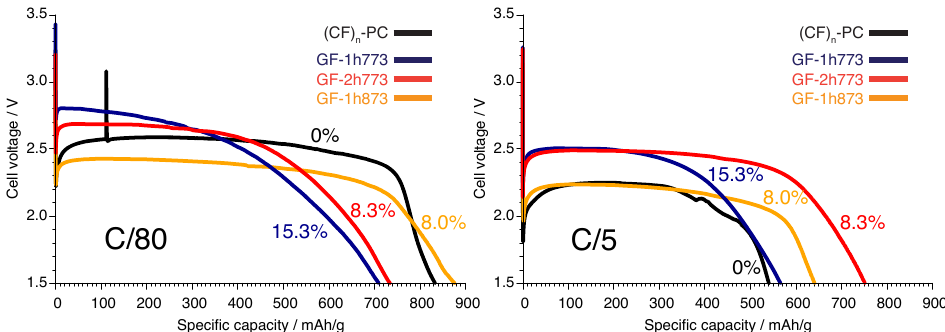
Figure 8. Galvanostatic discharge curves at C/80 (80 h discharge, left ) and C/5 (5 h discharge, right ) for Li/GF cells using the (C 4 F) n /(CF) n composite GFs as the active cathode material. Each curve is labeled with the fraction of (C 4 F) n in each sample (per mole C) as derived from our quantitative NMR analysis. “0%” corresponds to a reference Li/(CF) n